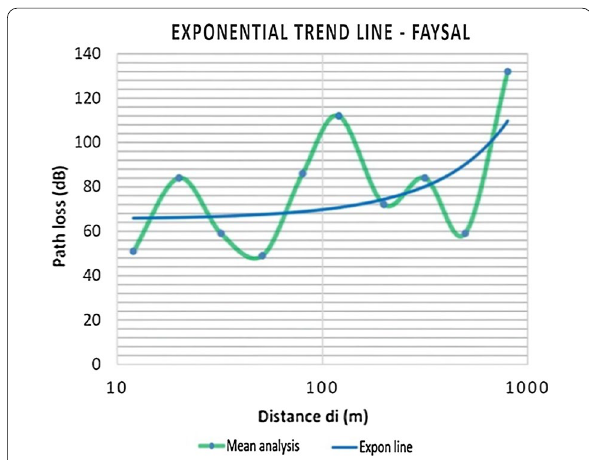
Fig. 7 Regression analysis—exponential trend line—Faysal